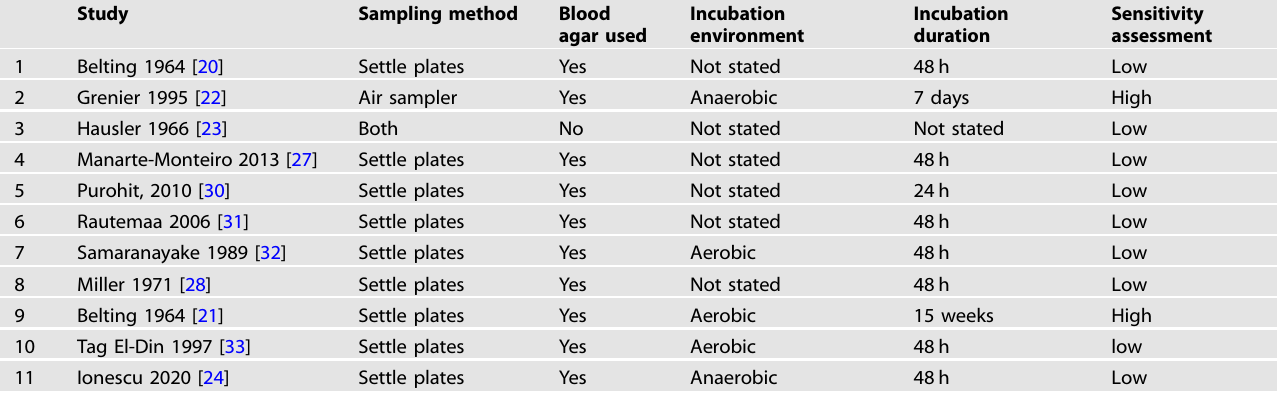
Table 5. Sensitivity measure of bacterial detection ( n = 12).